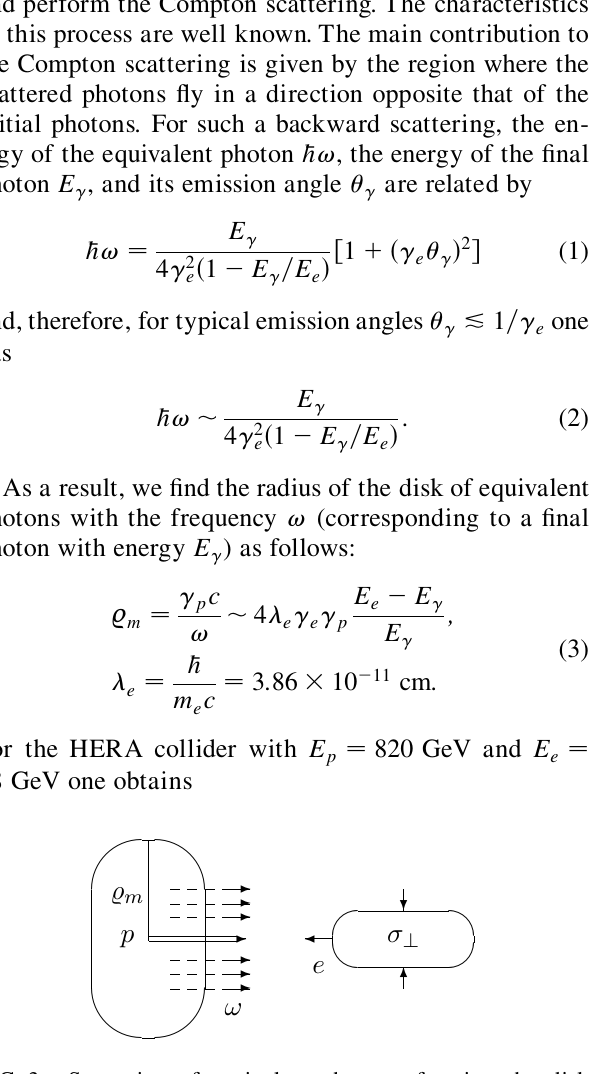
FIG. 1. Block diagram of radiation by the electron.